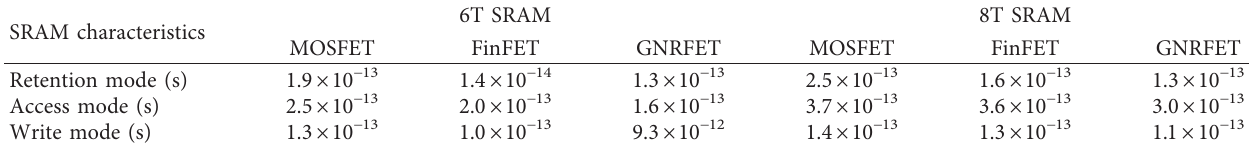
Table 6: Analysis of delay of MOSFET-, FinFET-, and GNRFET-based technology. SRAM characteristics